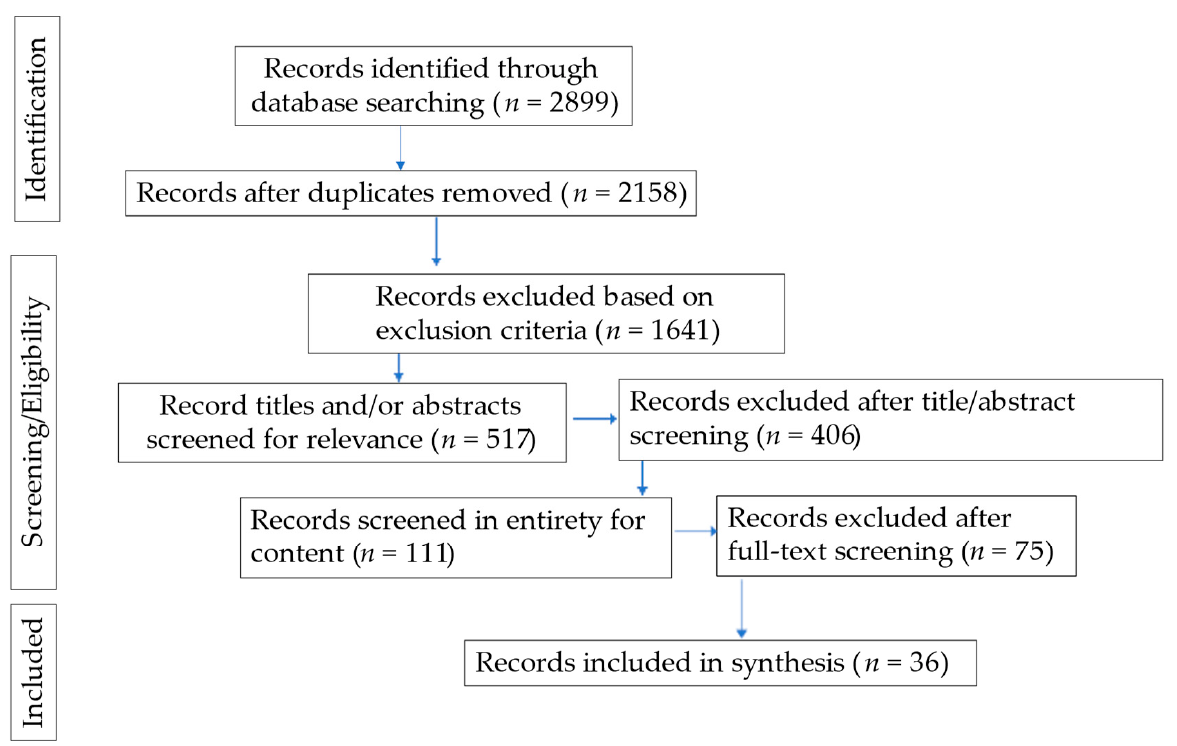
Figure 1. The PRISMA Group for reporting items for systematic reviews illustrating the record selection process.